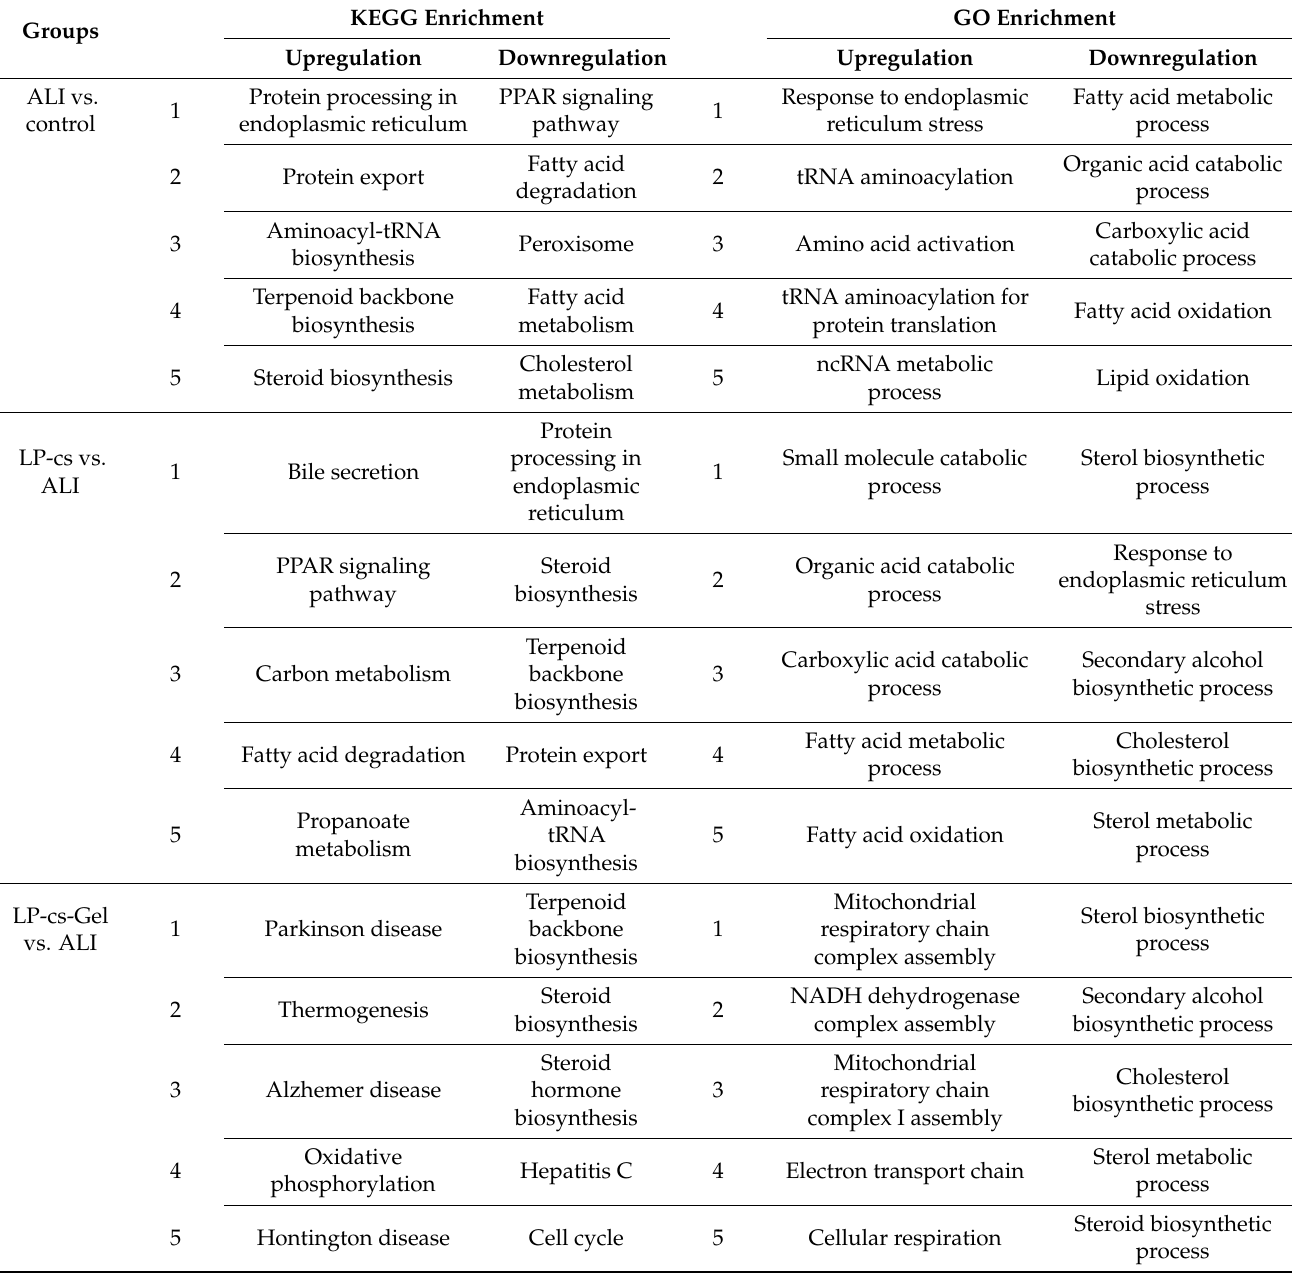
Table 2. Up- or downregulation in KEGG and GO enrichment (top